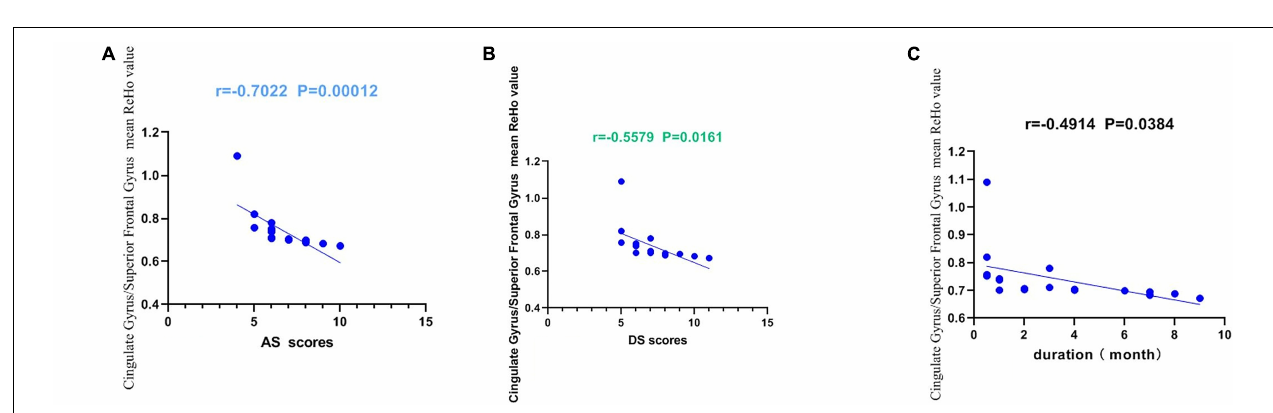
FIGURE 5 | Correlations between the mean ReHo values of the Cingulate Gyrus/Superior Frontal Gyrus and the clinical behaviors. (A) The AS showed a negative correlation with the mean ReHo values of the Cingulate Gyrus/Superior Frontal Gyrus ( r = − 0.702, p = 0.0001 < 0.001), (B) the DS showed a negative correlation with the mean ReHo values of the Cingulate Gyrus/Superior Frontal Gyrus ( r = − 0.5579, p = 0.0161 < 0.05). (C) The duration showed a negative correlation with the mean ReHo values of the Cingulate Gyrus/Superior Frontal Gyrus ( r = 0.4914, p = 0.0384 < 0.05). AS, anxiety scores; DS, depression